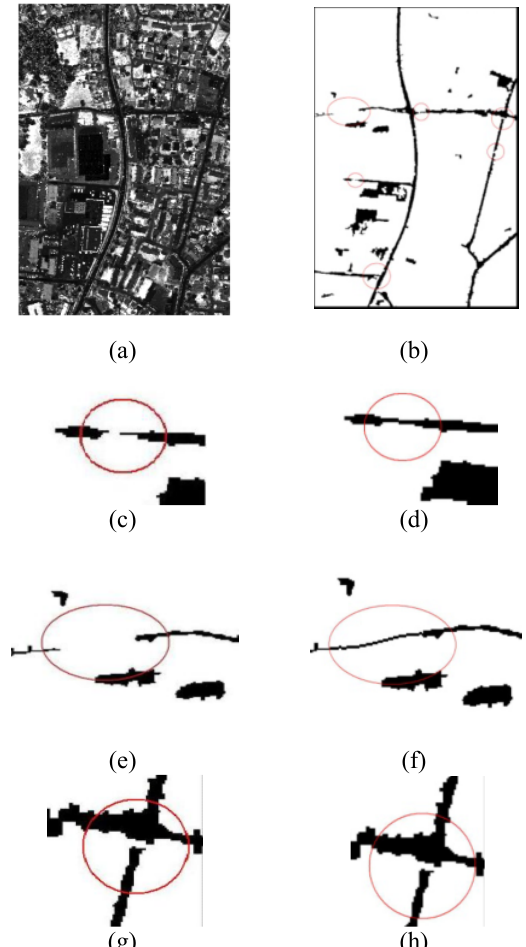
Figure 8. Result of gap filling algorithm. (a) Aerial image. (b) Detected road before gap filling. (c) A small gap. (d) Algorithm succeeded in filling the small gaps. (e) A large gap. (f) Algorithm succeeded in filling the large gaps. (g) A gap in intersection. (h) Algorithm failed to fill the gaps in